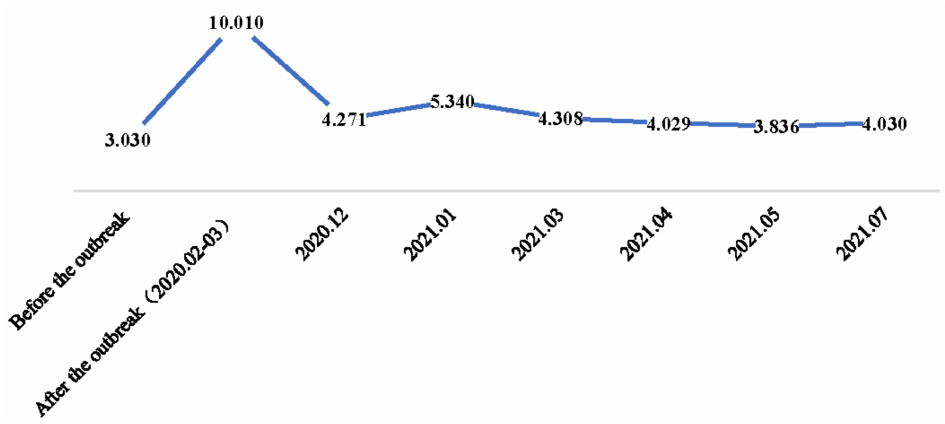
Figure 5. The difference in the scale of food reserves before and after the COVID-19.